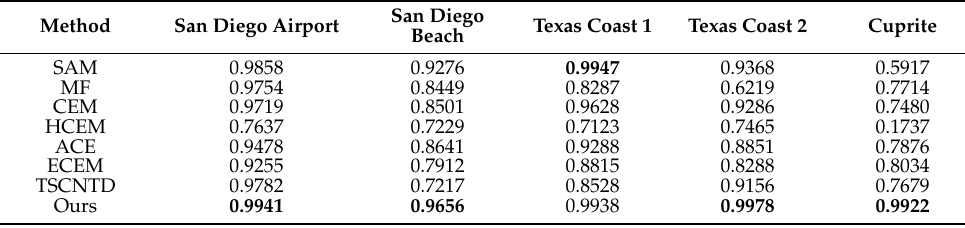
Table 3. The AUC values of different algorithms on five real data sets. The best results are reported in